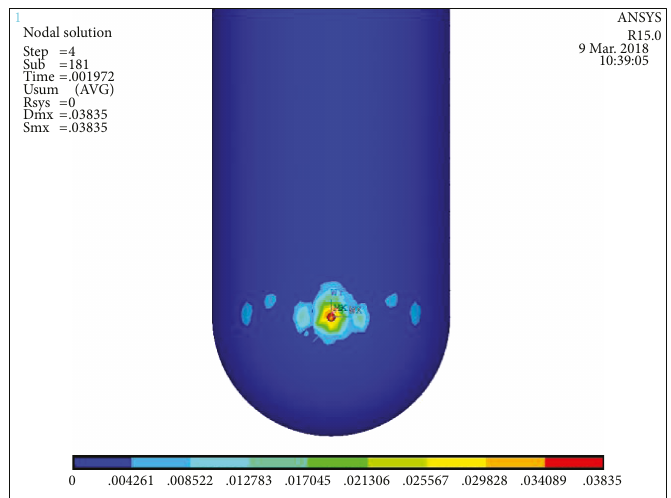
Figure 20: Displacement distribution of the whole